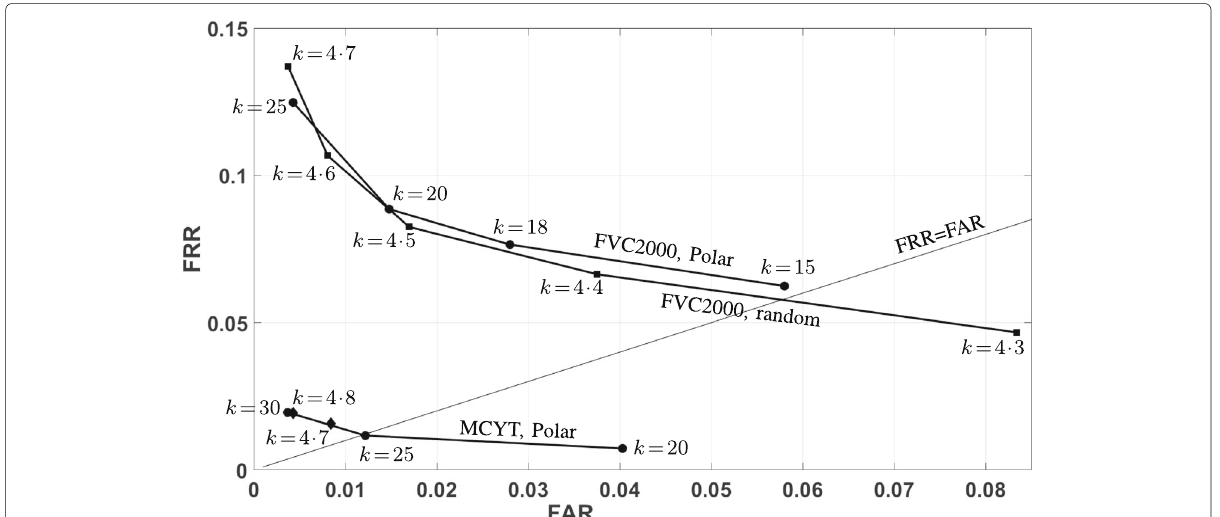
Fig. 13 FRR versus FAR achieved by Polar codes and random codebooks (average over three random codebooks). The (cid:2) markers denote random codebook, and happen to coincide with the line connecting the Polar markers